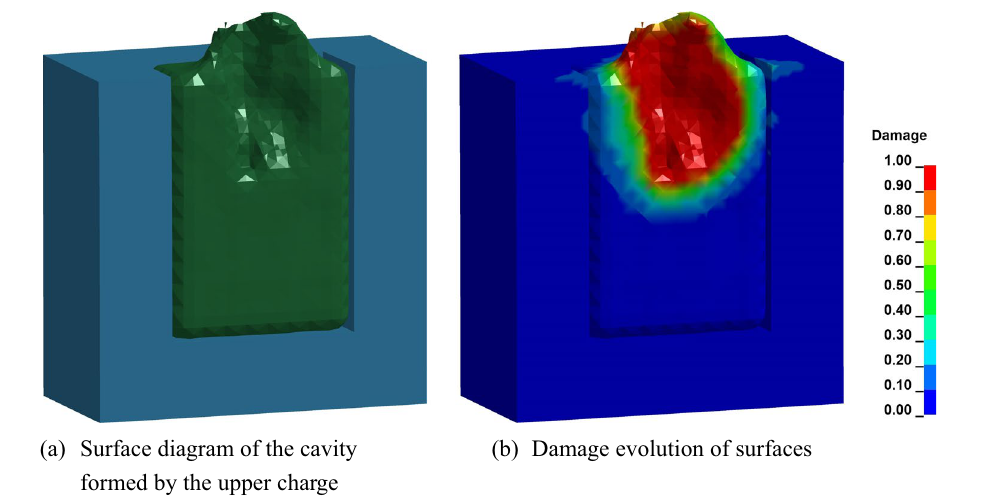
Fig. 11 Cavity surface map of deep hole dispersed charge cut blasting at 8.39 ms. a Surface diagram of the cavity formed by the upper charge; b Damage evolution of surfaces